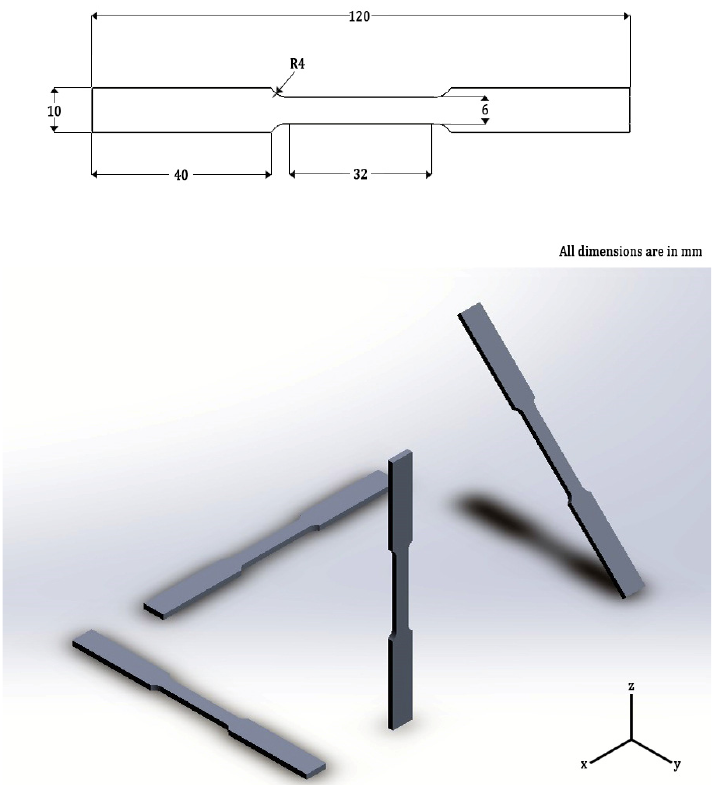
Figure 1. Dog-bone shaped specimens built in four different configurations in SLM building platform and their dimensions.